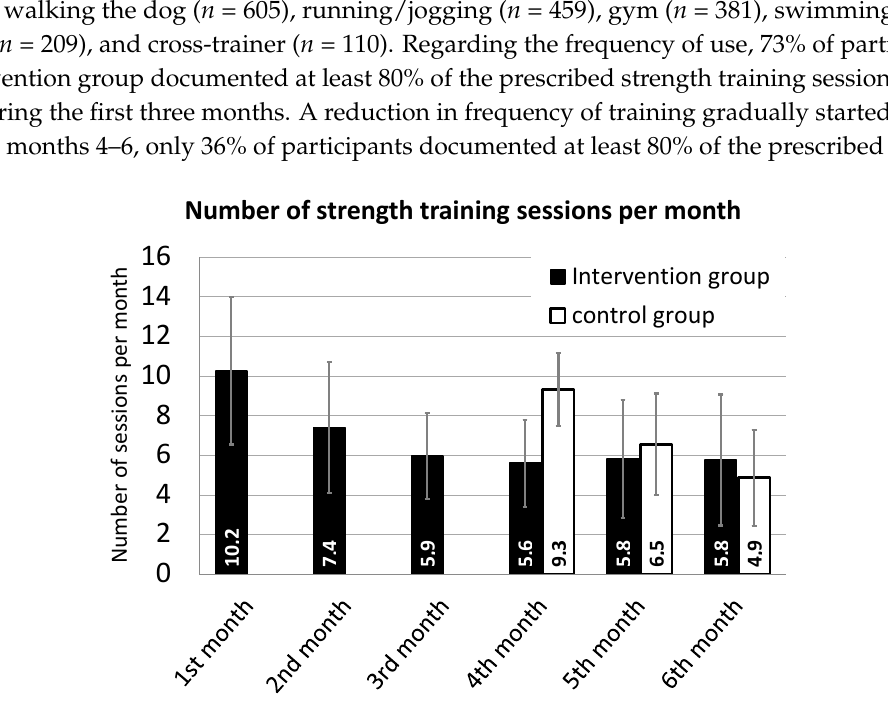
Figure 2. Compliance over the study period.